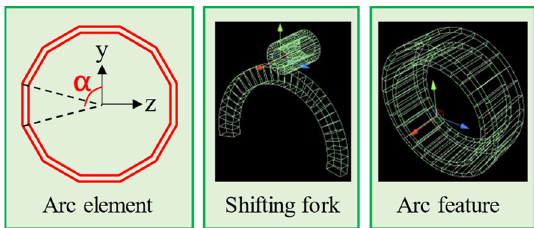
Figure 12. Arc feature mesh solid model. R contour, is the outer diameter of the contour. In contrast,